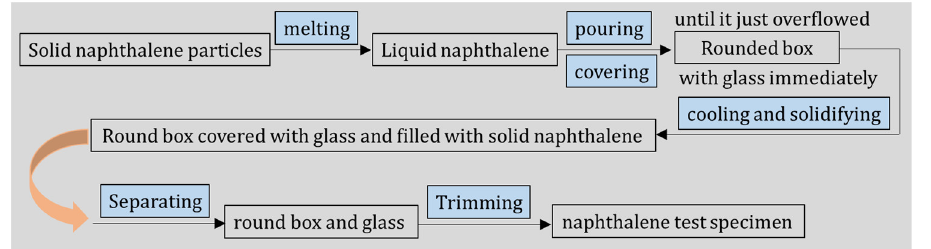
Figure 2. Production process of the naphthalene specimen.